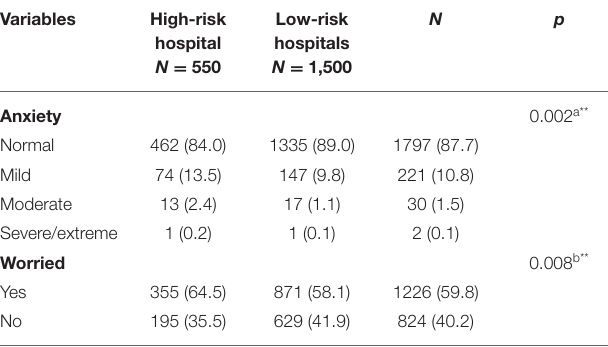
TABLE 6 | Different severity levels of anxiety and worry among the